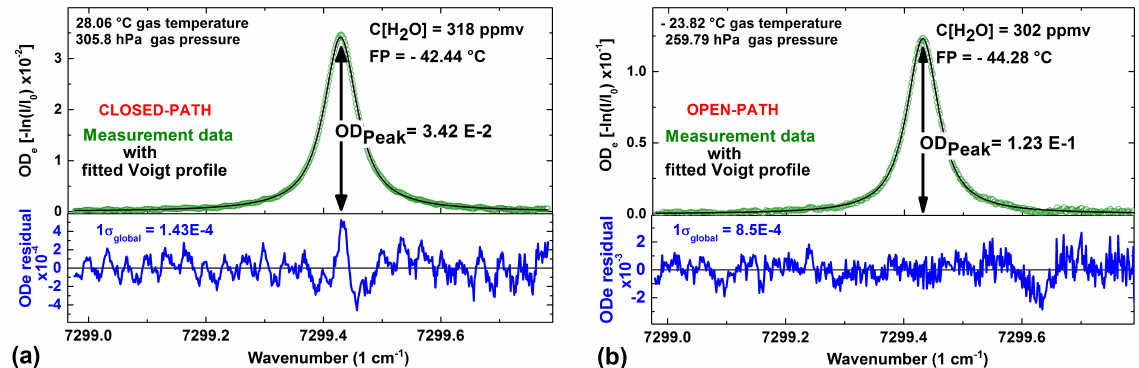
Figure 8. Comparison of pre-processed TDLAS scans (similar to Fig. 7) of HAI’s 1.4µm closed-path (left) and the 1.4µm open-path (right) cell during a HALO flight. Despite the entirely different measurement conditions such as wind speed (cms − 1 to 100ms − 1 ) or temperature ( + 28 to − 23 ◦ C), both channels are evaluated calibration-free with the exact same methods and model.